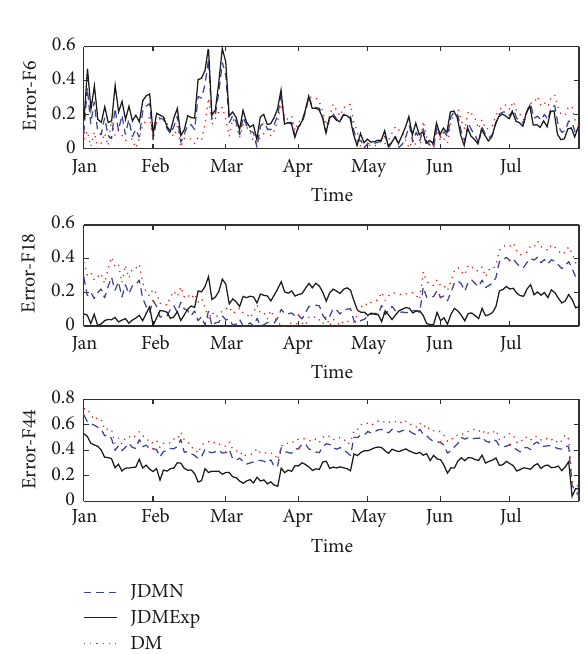
Figure 1: Absolute error of the futures prices for the out-of-sample (January–July 2015) with maturities: 6, 18, and 44 months. The absolute error for the DM is the red dotted line, the JDMN is the blue dash line, and the JDMExp is the black solid